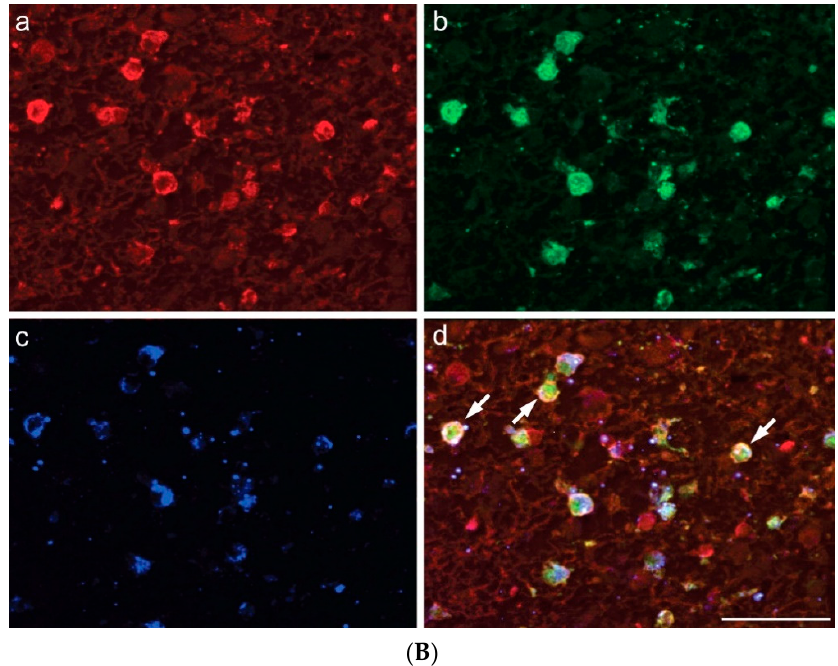
Figure 4. ( A ) Coexpression of SOAT1 and GFAP in glioblastoma: ( a ) SOAT1; ( b ) GFAP; ( c ) Solanum tuberosum lectin (STL) staining of vessels and microglia/macrophages; ( d ) merge (scale bar 200 µm). ( B ) Coexpression of SOAT1 and Iba1 in glioblastoma (arrows): ( a ) SOAT1; ( b ) Iba1; ( c ) STL; ( d ) merge (scale bar 100 µm).